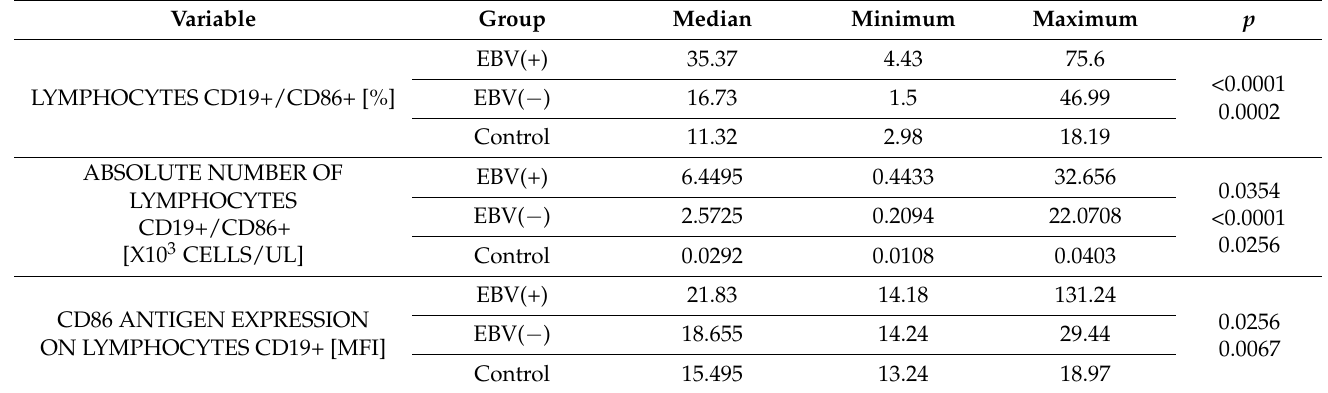
Table 2. CD86 expression in controls, EBV( − ) patients with CLL, and EBV(+) patients with